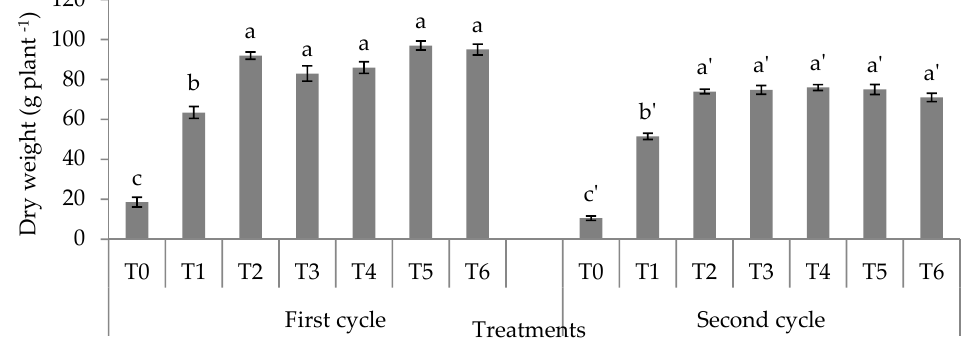
Figure 10. Effects of treatments on dry weight of maize aboveground biomass. Means with the same letter above the bars within a crop cycle are not significantly different at p ≤ 0.05. Bars represent the mean values ± standard error .